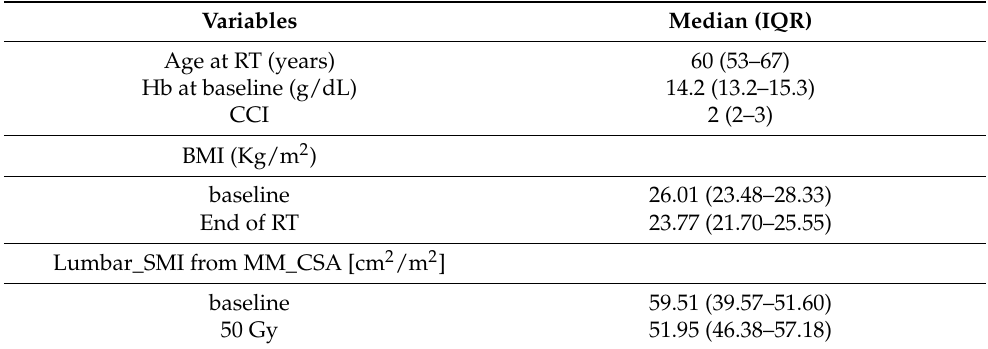
Table 1. Patients’ cohort